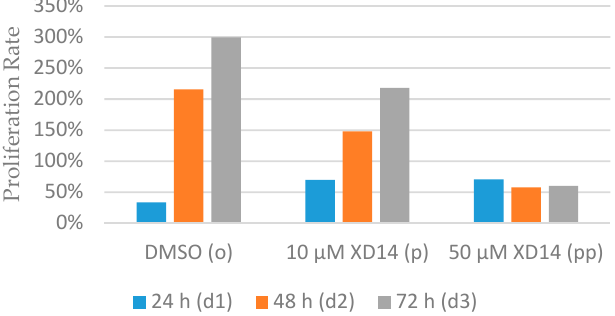
Figure 2. Proliferation rate of MCF-7 cells after treatment with DMSO (group o) or XD14 (group p and pp) for 24, 48, and 72 h. The proliferation rate was calculated based on the cell number of d (day)1, d2 and d3 compared to d0.